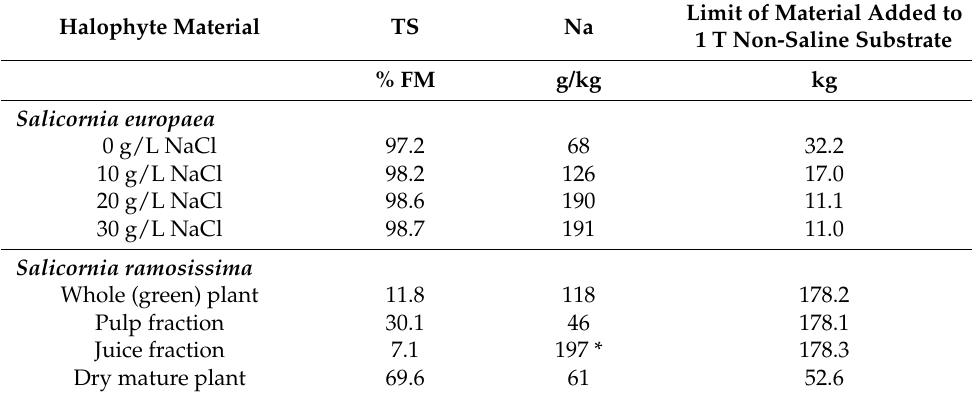
Table 7. Limit of Salicornia material that can be added in co-digestion with 1 ton (t) of non-saline substrate to reach Na concentration of 2400 mg Na/L, based on TS concentration of the material and Na concentration in g/kg in the BMP batch-test set-up. Limit of Material Added Halophyte Material TS Na